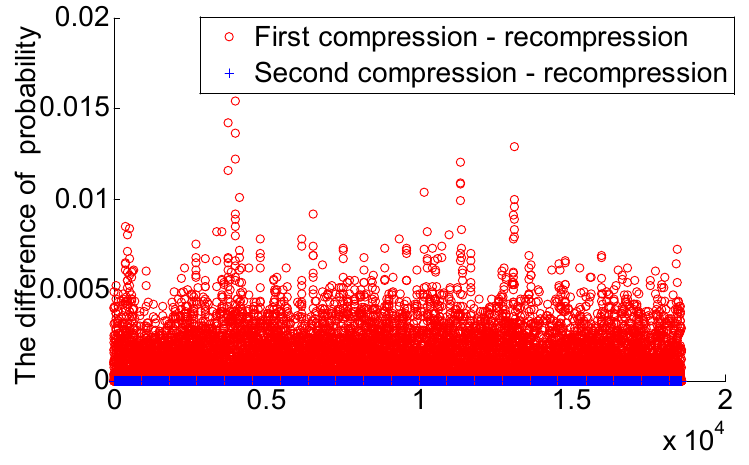
Figure 4. Distribution of probability difference of audio and recompression audio scale factor.